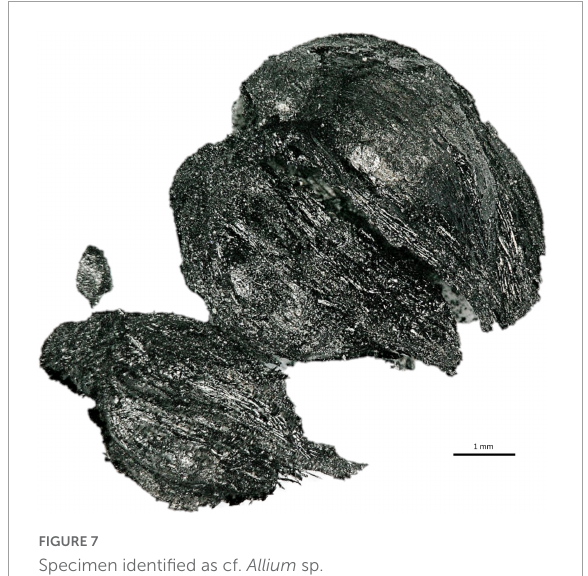
FIGURE7 Specimen identified as cf. Allium